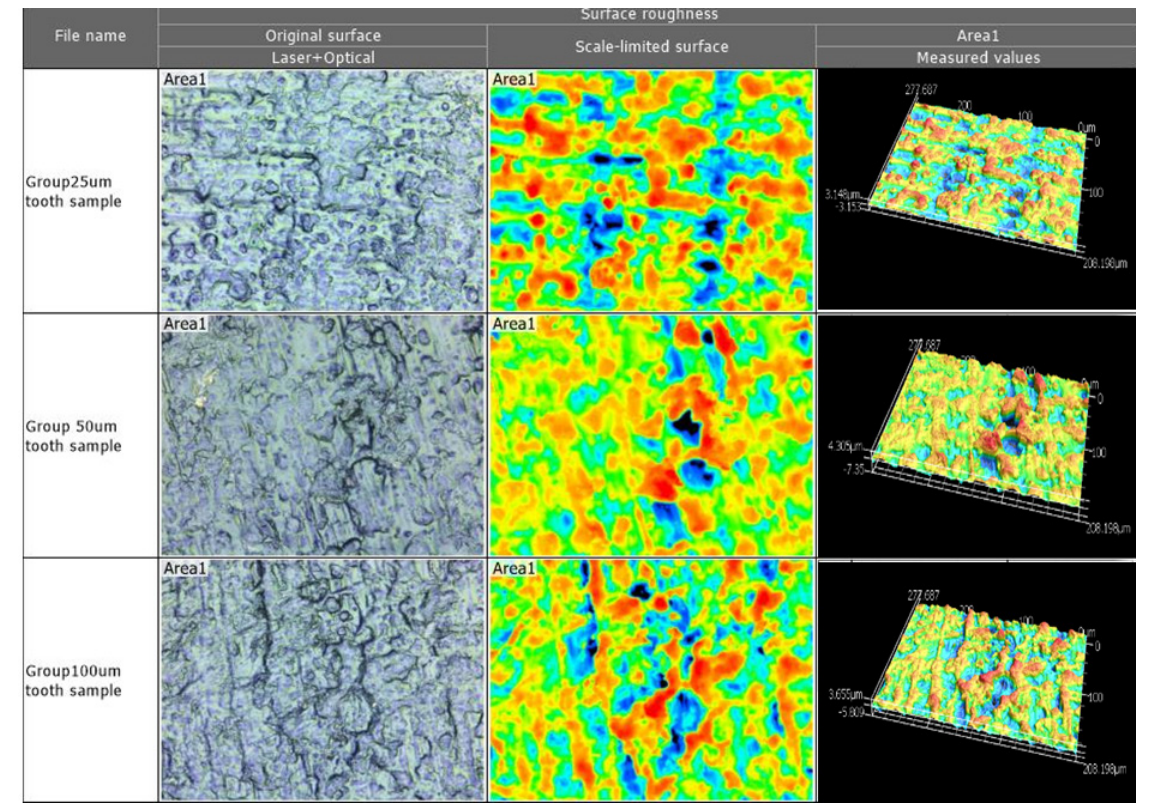
Figure 3. The surface roughness of the tooth die surface for each of the three groups in magnified 3D. Taken by Profile- analyzing Laser Microscope VK-X100 series, Keyence@.